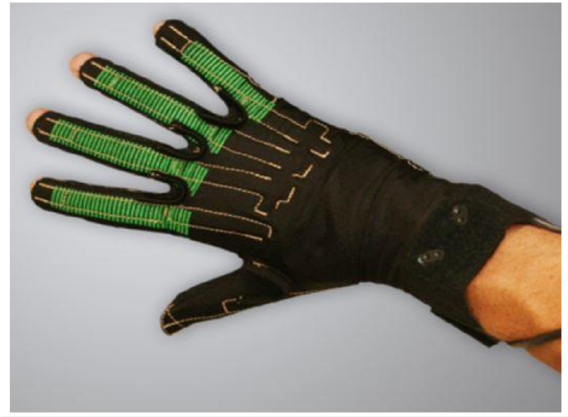
Figure 21. CyberGlove III